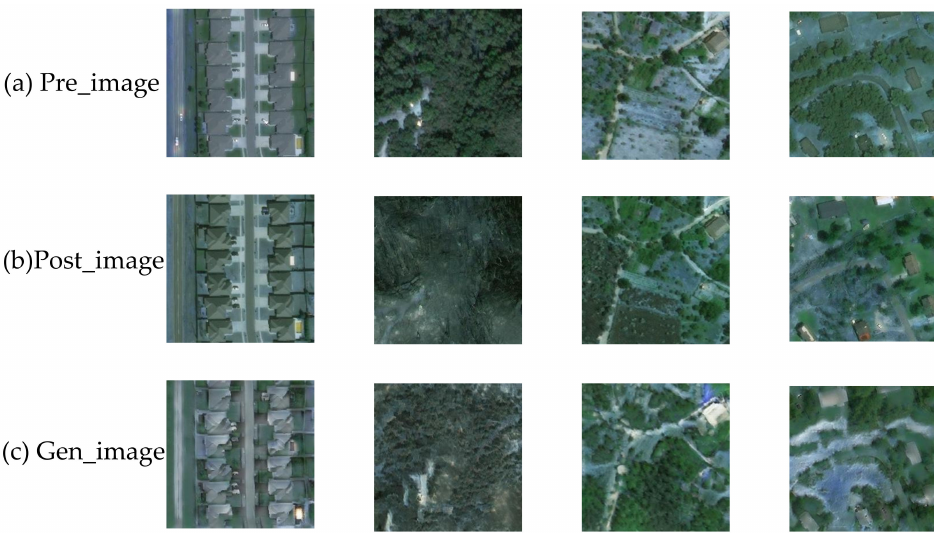
Figure 5. Single attributes-generated images results. ( a – c ) represent the pre-disaster, post-disaster images, and generated images, respectively, each column is a pair of images, and here are four pairs of